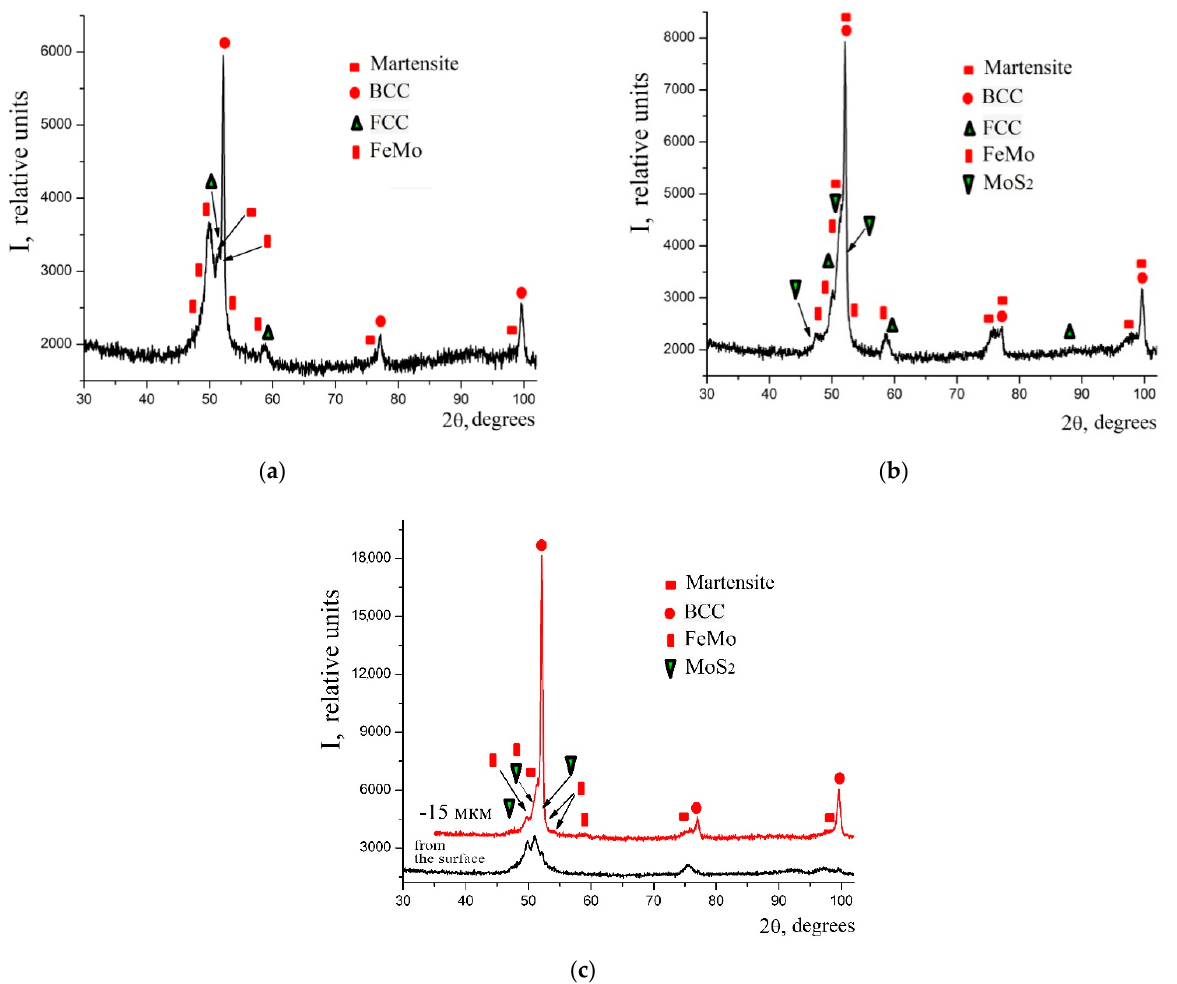
Figure 10. Diffractograms of sulfomolybdenum coatings obtained by ESA method on steel C22: ( a ) Wp = 0.13 J; ( b ) Wp = 0.55 J; ( c ) Wp = 3.4